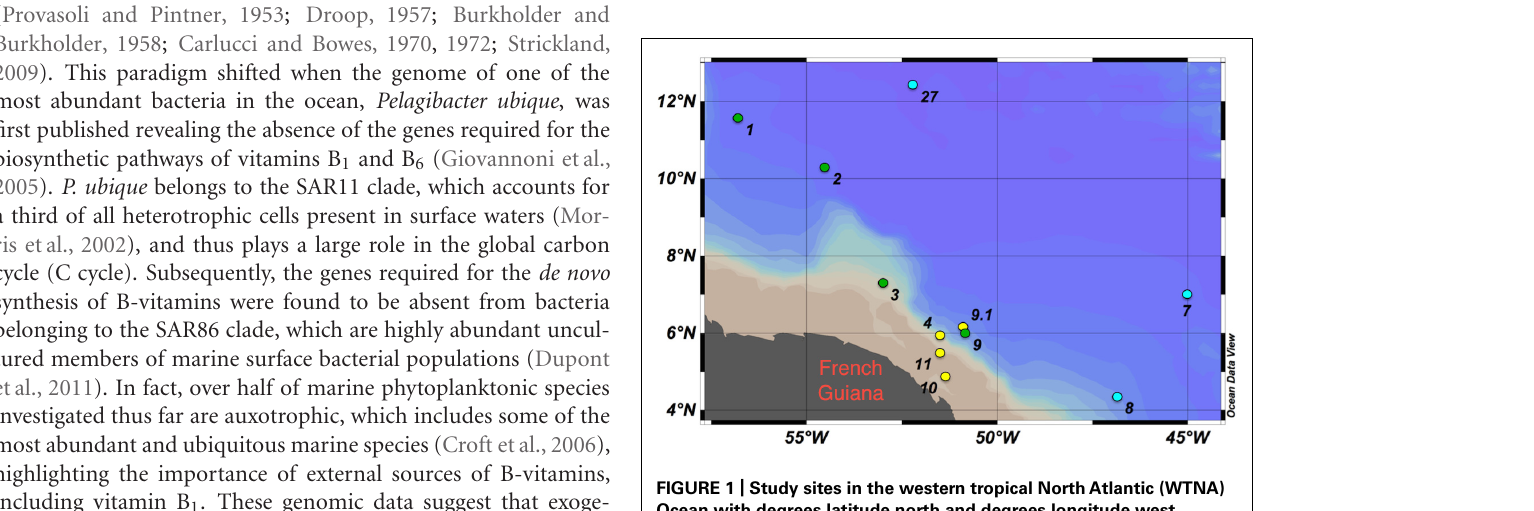
shown. Stations clustered by sea surface salinity (SSS): low-salinity stations (SSS < 30, yellow circles), mesohaline stations (30 < SSS > 35, green circles), and oceanic/open ocean stations (SSS > 35, blue circles). Ocean data view (Schlitzer,